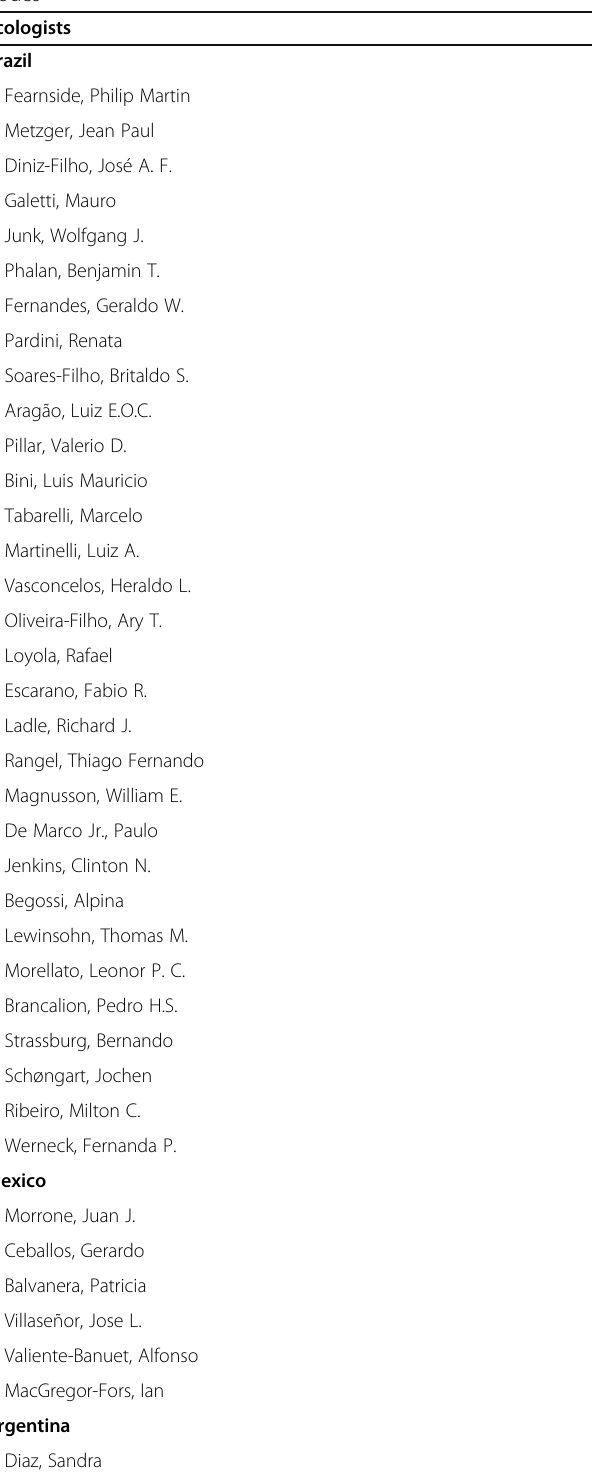
Table 4 Single-year (2019) impact ranking of Latin American ecologists, their No. allocites, and No. papers in the Scopus database (from Table S-7, 2019 Single-year ranking, by Ioannidis et al. [3]). For the global sample, countries are identified by their ISO 3166